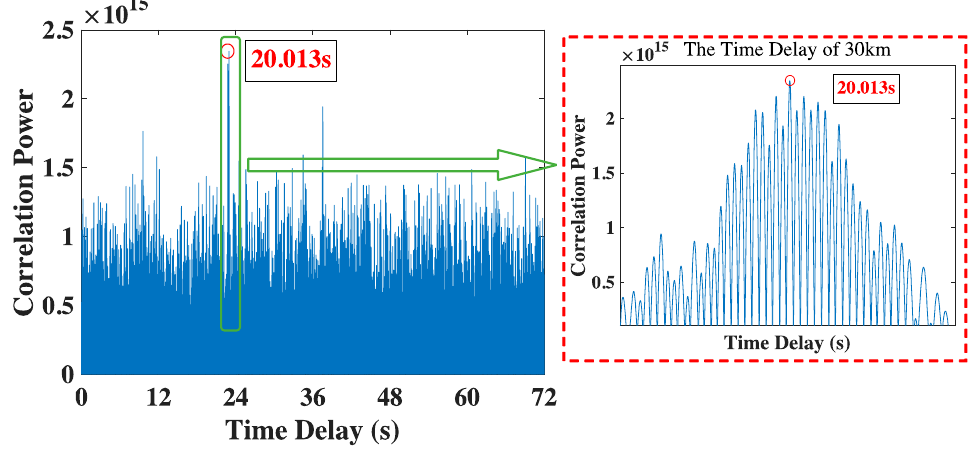
Figure 7. The time delay result of 20 km.